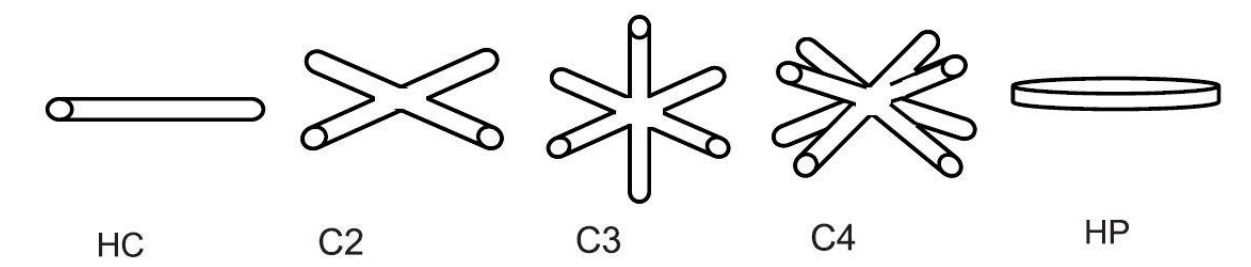
Figure 4. Snowflakes models used by Kim et al. [54] for their DDA calculations in the physical model of snow retrieval: Hollow column (HC), snow aggregates composed by two cylinders (C2), three cylinders (C3), four cylinders (C4), and hexagonal plates (HP). [Courtesy of the American Geophysical Union]